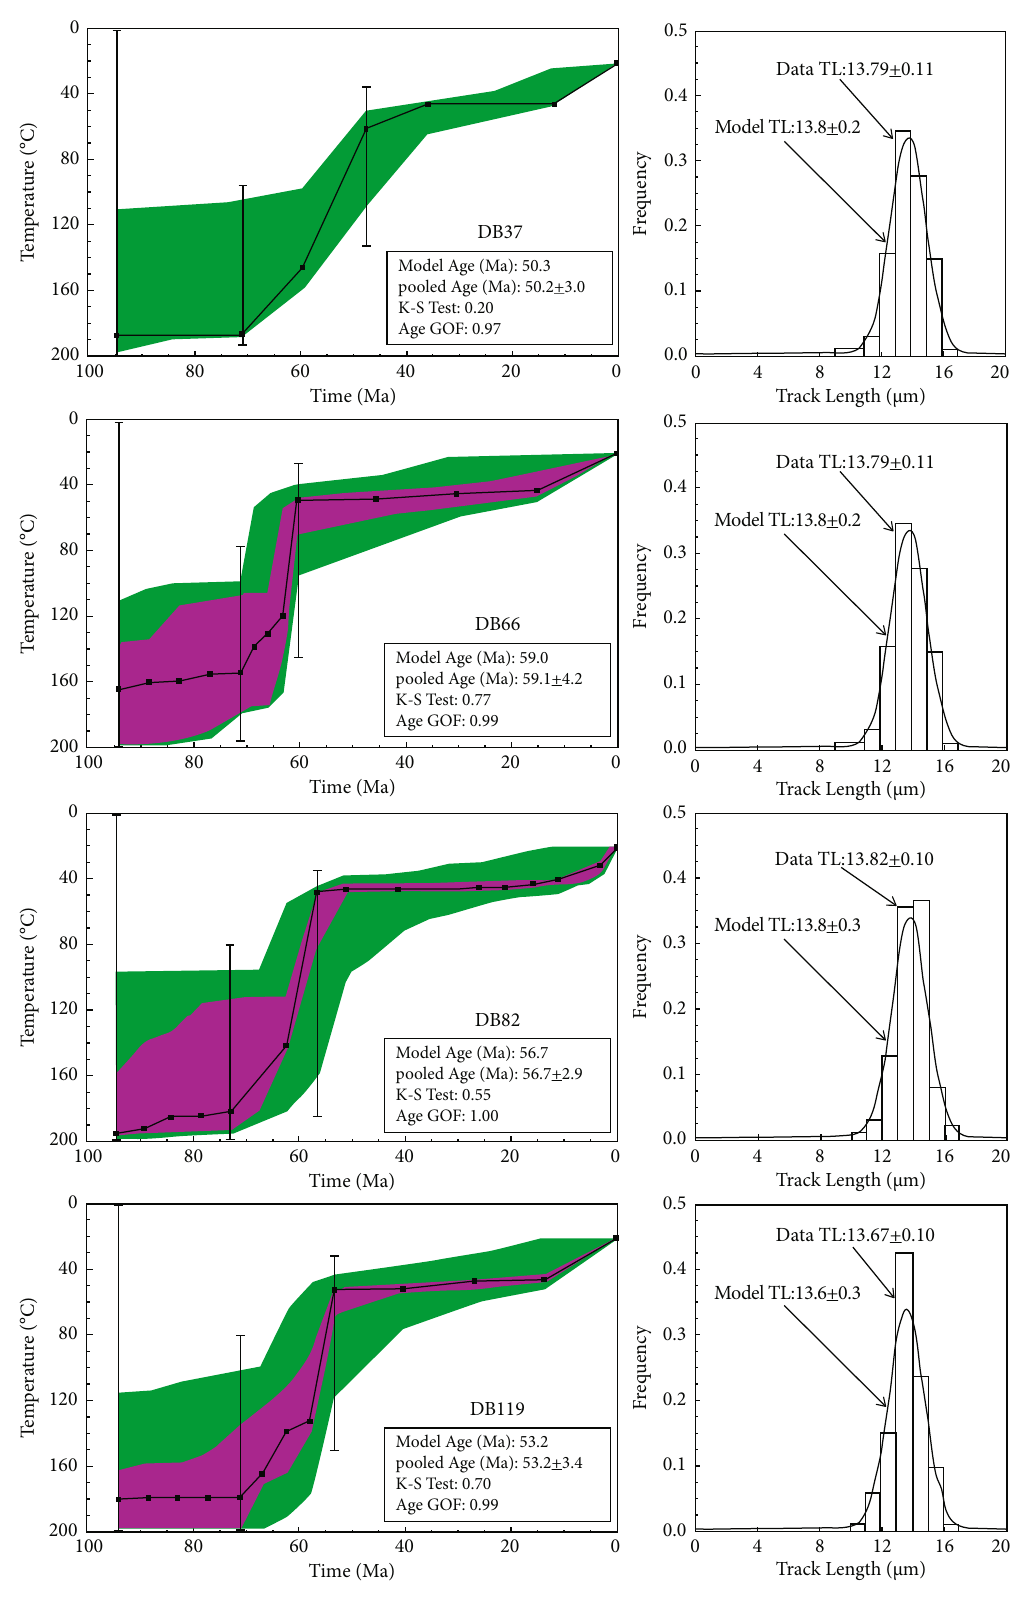
Figure 6: Exhumation history simulation diagram of AFTs and histogram of AFT length distribution in the ore-hosting rock body. The solid line marks the best- fi t time-temperature path from which the simulated data were derived. Green regions mark envelopes of statistically acceptable fi ts. Magenta regions indicate envelopes for statistically good fi ts. I-bars mark user-entered time-temperature